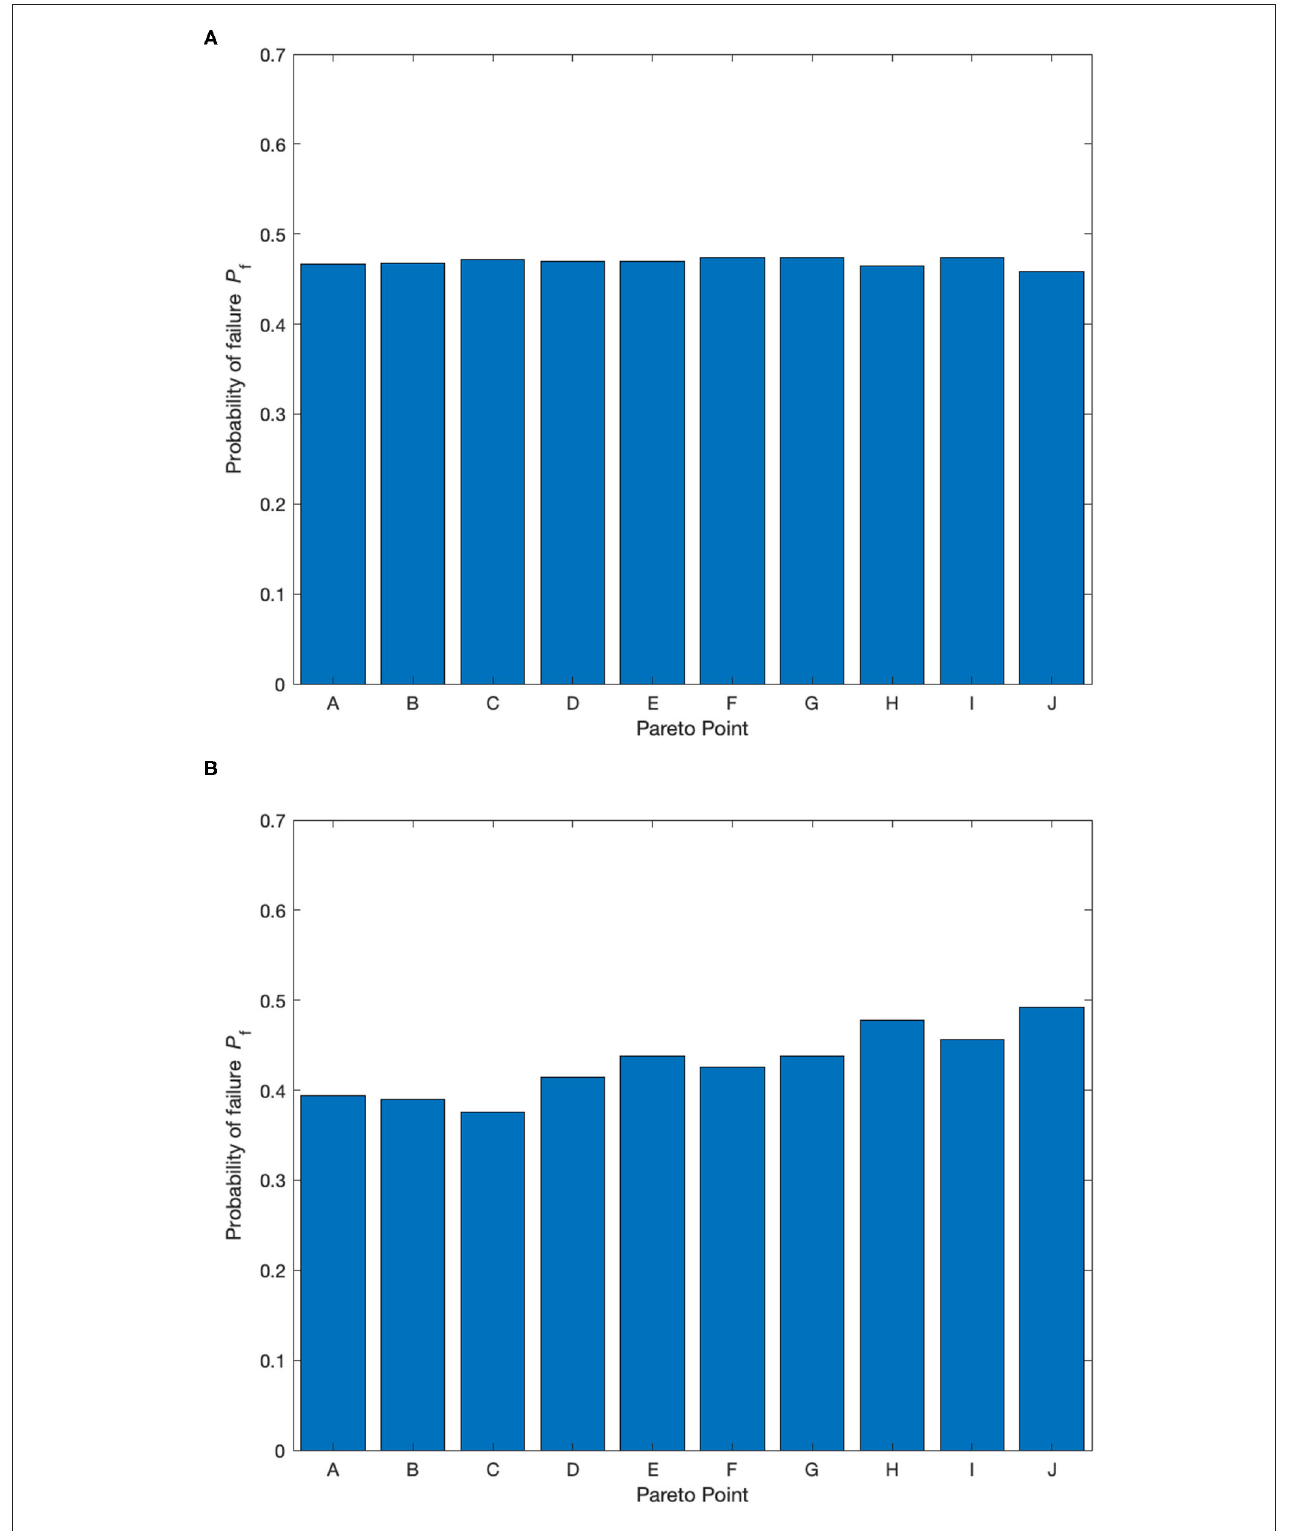
FIGURE 6 | (A) At the 10 Pareto optimal points as obtained from MOO, the probability of failure when BTEX emission exceeds as given in Table 1 lies between 0.46 ≤ P f ≤ 0.47; (B) At the 10 Pareto optimal points as obtained from MOO, the probability of failure when BTEX emission exceeds as given in Table 1 lies between 0.38 ≤ P f ≤